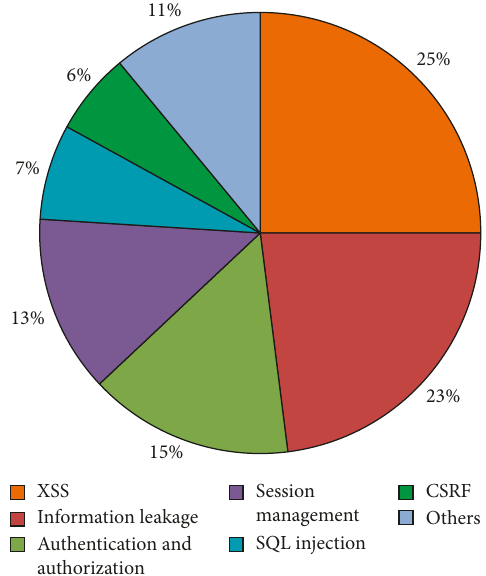
Figure 1: Cenzic Application Vulnerability Trends Report (2013). Source: http://info.cenzic.com/rs/cenzic/images/Cenzic-Application-